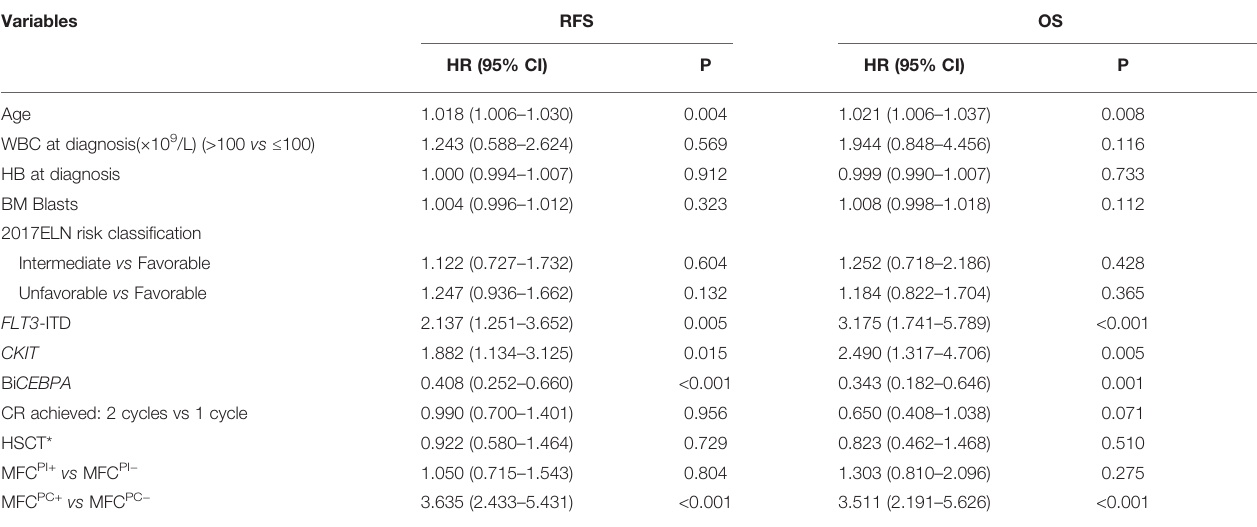
TABLE 2 | Multivariate Analysis of Prognostic Variables for RFS and OS.